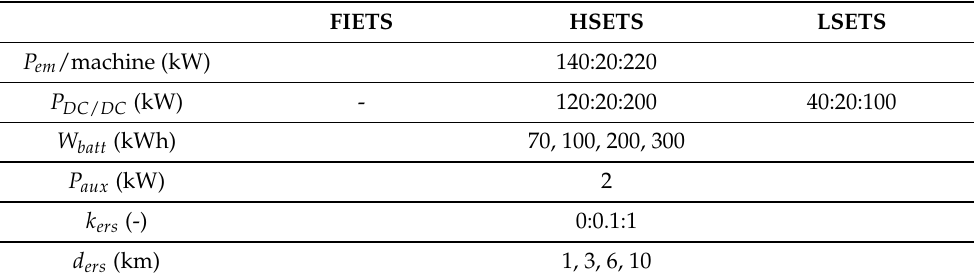
Table 3. Ratings of powertrain components and